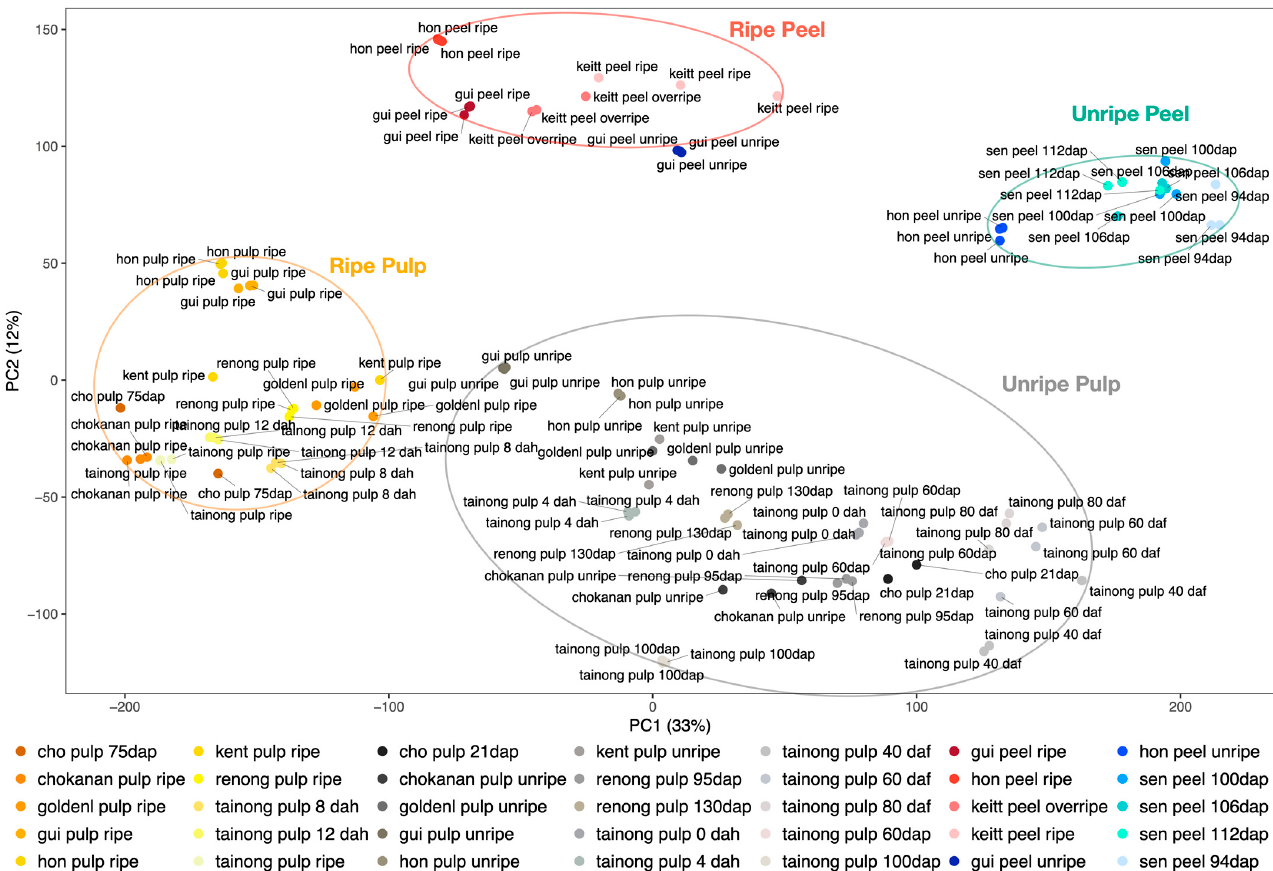
Figure 3. Principal component analysis (PCA) of mango expression data. Ripe pulp (grouped in an orange ellipse), ripe peel (in a red ellipse), unripe peel (in a green ellipse), and unripe pulp (grouped in a gray ellipse) samples are clustered in separated groups.